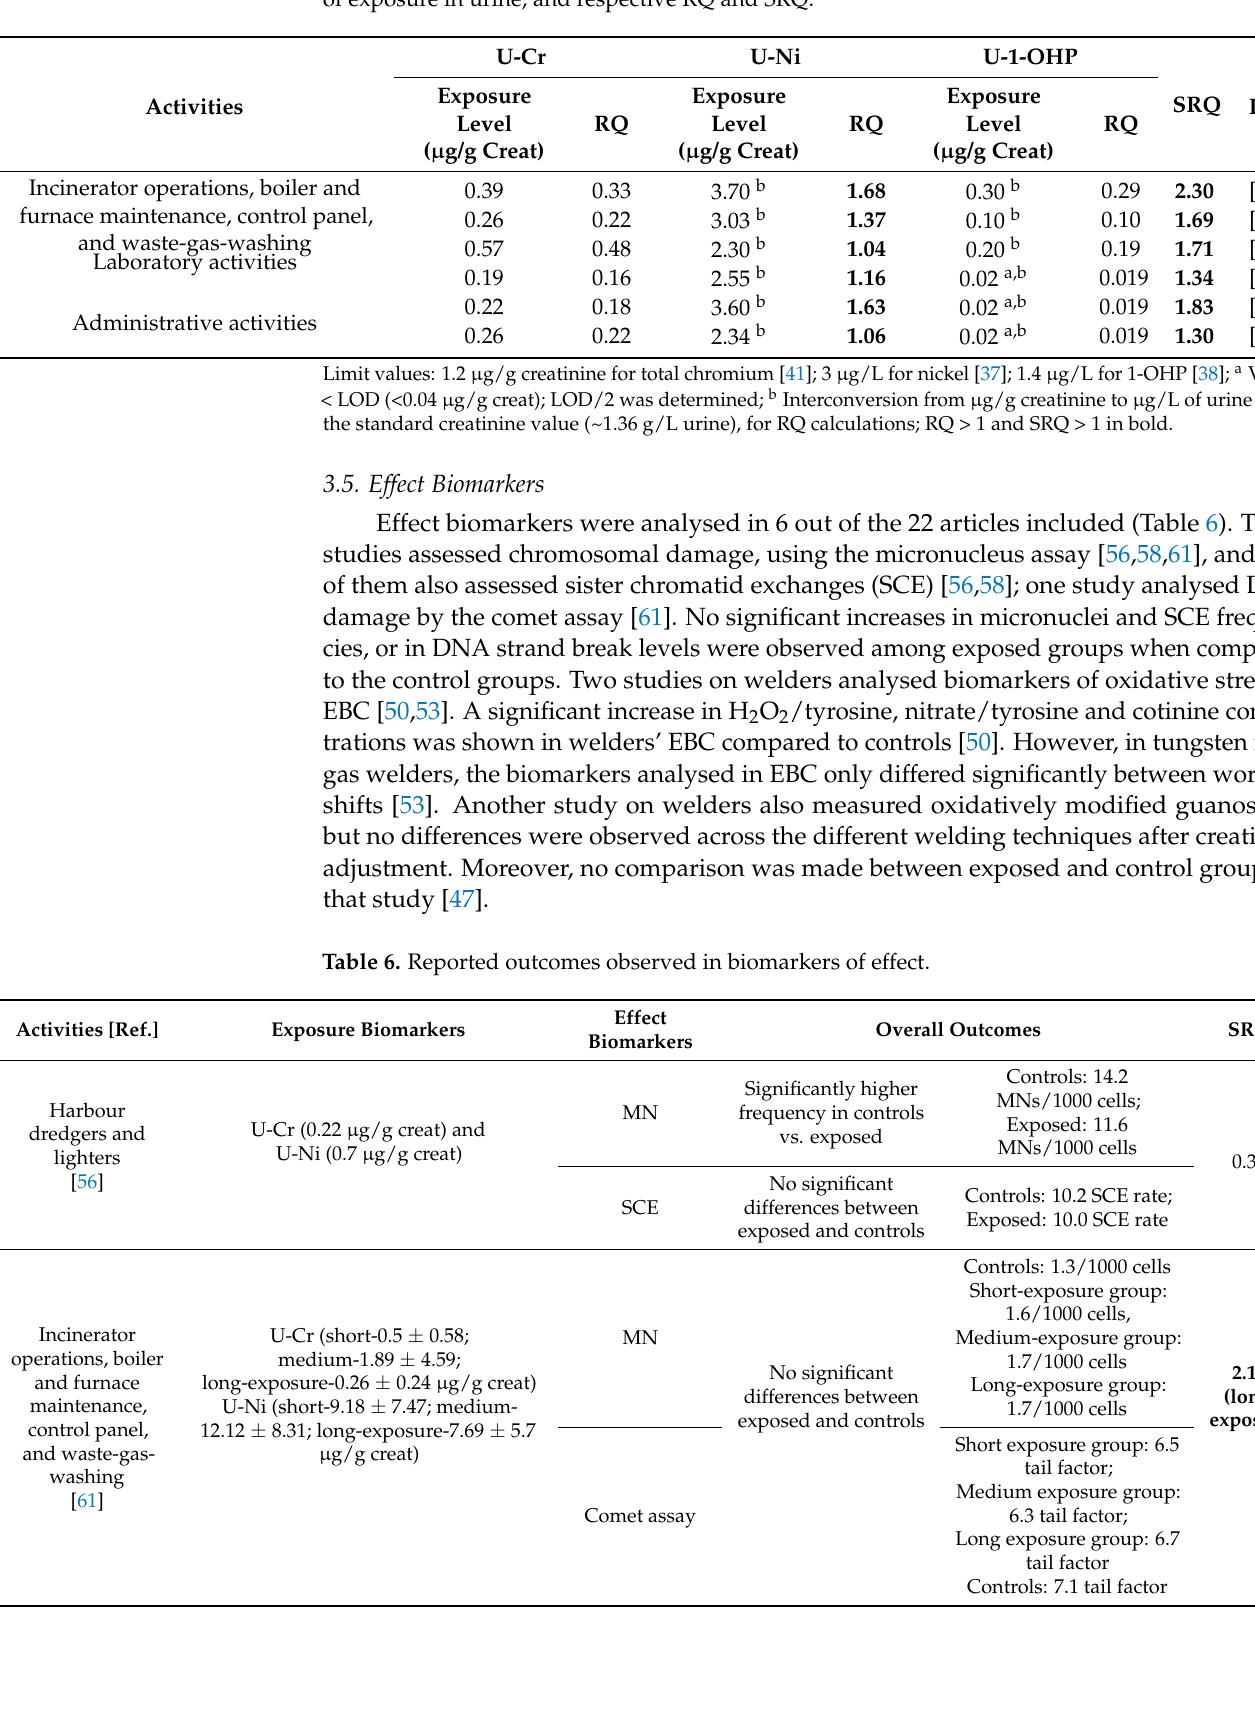
Table 5. Occupational exposure to Cr, Ni and PAHs in hazard waste incinerators, based on biomarkers of exposure in urine, and respective RQ and SRQ.